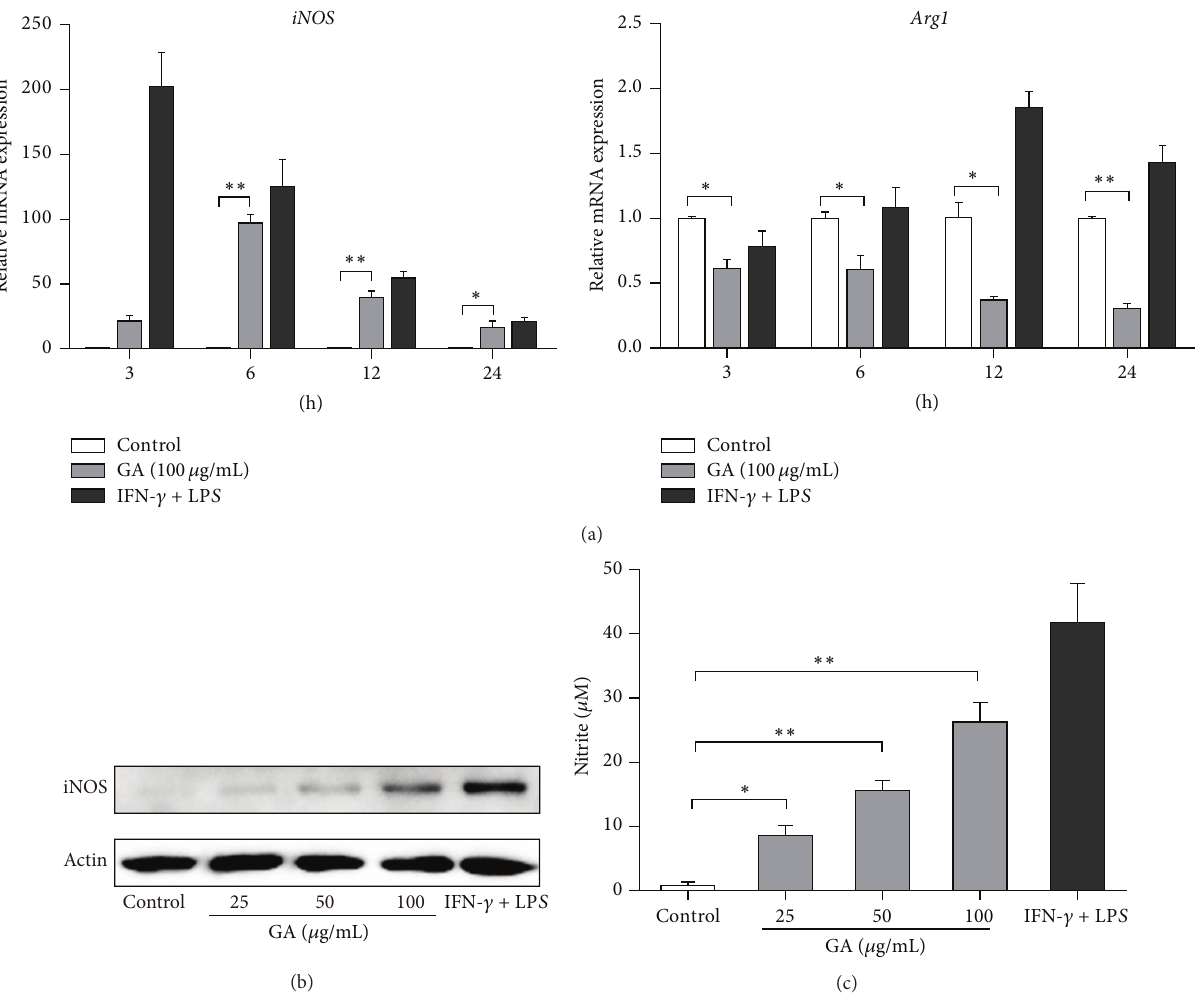
Figure 5: Effect of GA on NO synthesis in BMDMs. BMDMs were treated with GA (25 ∼ 100 𝜇 g/mL). (a) At the indicated time points, total RNAwasextractedandtheexpressionsof iNOS and Arg1 weremeasuredbyreal-timePCR.(b,c)After24 hoftreatment,cellsandsupernatants were collected, cell lysates were prepared and subjected to western blotting with iNOS and 𝛽 -actin antibody, and the nitrite generation in the supernatants was quantified as described in Section 2. Data are mean ± SD for three independent experiments. ∗ 𝑃 < 0.05 , ∗∗ 𝑃 < 0.01 ( 𝑡